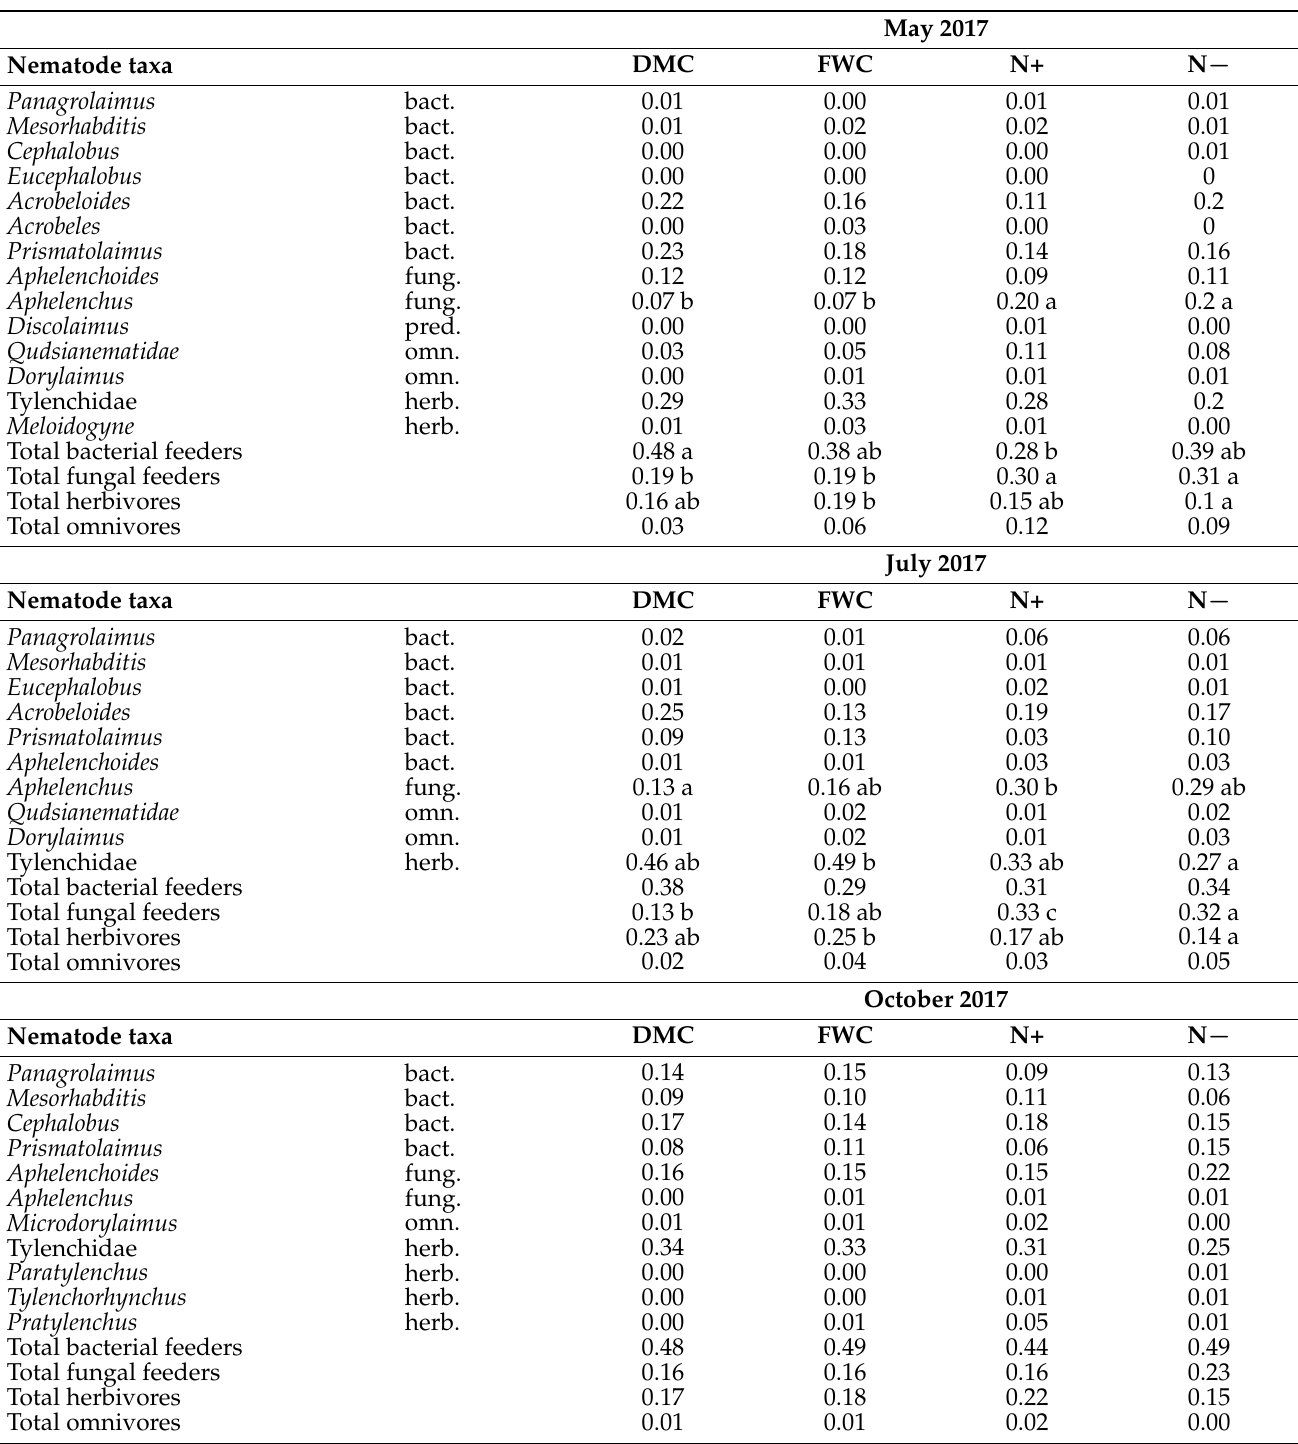
Table 4. The average relative abundance of individual nematode groups in year two from an almond orchard receiving different organic amendments. Letters denote statistical differences of p < 0.05 determined by post hoc Tukey’s honestly significant difference (HSD) test. DMC = Dairy manure compost, FWC = Food waste compost, N+ = nitrogen fertilizer, and N − = unamended control. For trophic groupings of nematodes bact. = bacterial feeders, fung. = fungal feeders, pred. = predators, omn. = omnivores, and herb. = root herbivores. Categories with 0 values indicate relative abundances under 0.01